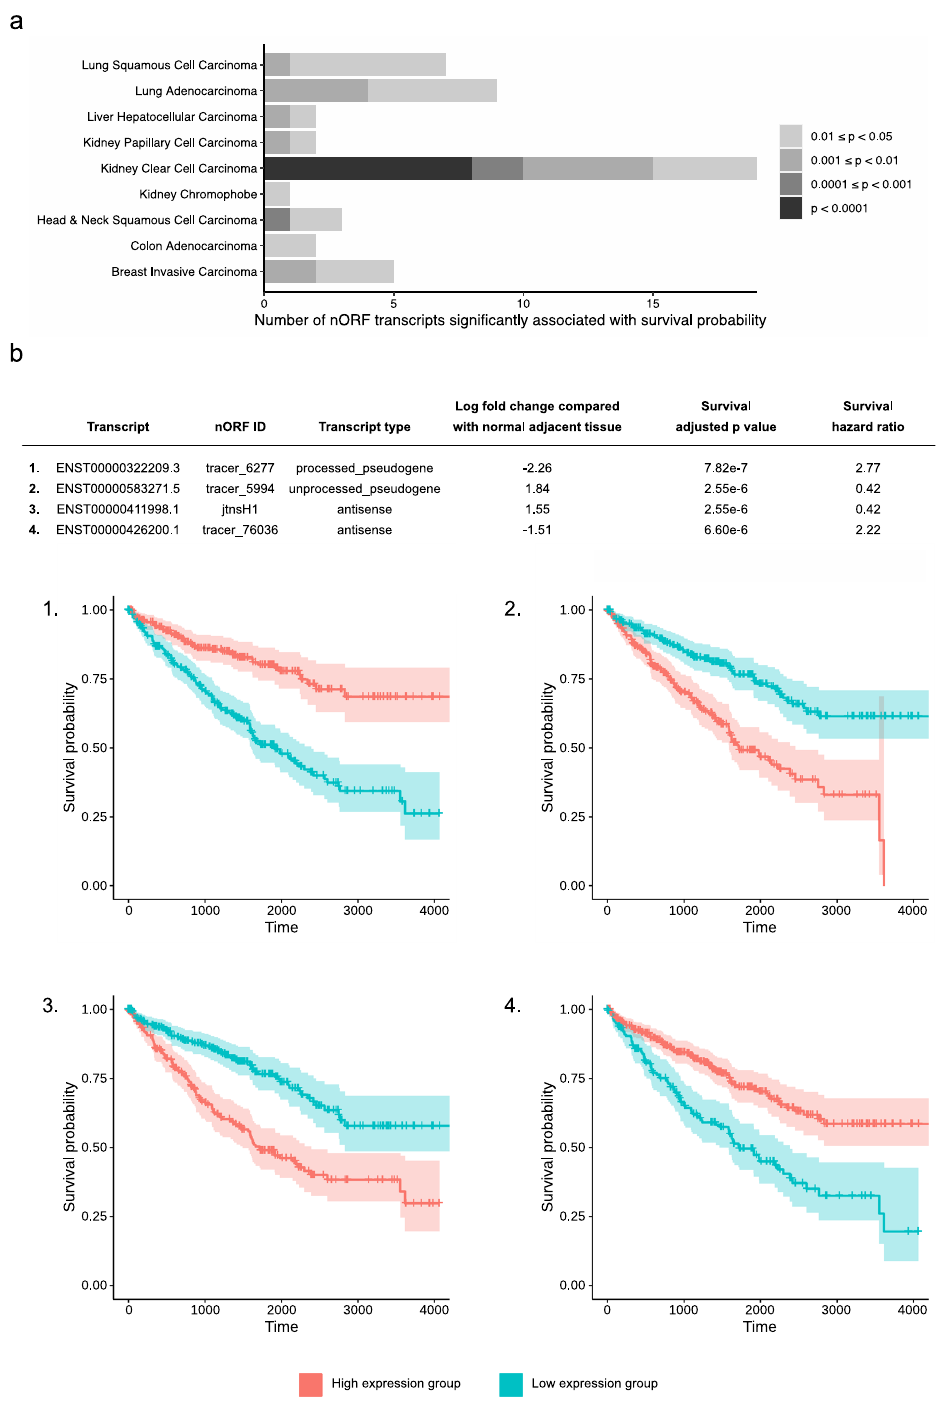
Fig. 3 Survival analysis of nORF transcripts. a Association of nORF transcript expression with overall patient survival. Number of differentially expressed nORF transcripts signi fi cantly associated with survival at different adjusted p -value thresholds, by cancer type. b Kaplan – Meier curves showing overall patient survival in high and low expression groups for reproducibly differentially expressed nORF transcripts. Showing Kaplan – Meier curves, nORF transcript ID and further transcript details for the four nORF transcripts most signi fi cantly associated with prognosis, in Kidney Clear Cell Carcinoma. The cohort was divided into high and low nORF transcript expression groups using the maximally selected rank statistic, and Kaplan – Meier survival curves were generated with a 95% con fi dence interval. Survival probabilities were compared using the log-rank test and p -values adjusted for multiple testing. Overall survival times were fi tted to a Cox proportional hazards regression model and hazard ratio calculated from the fi tted coef fi